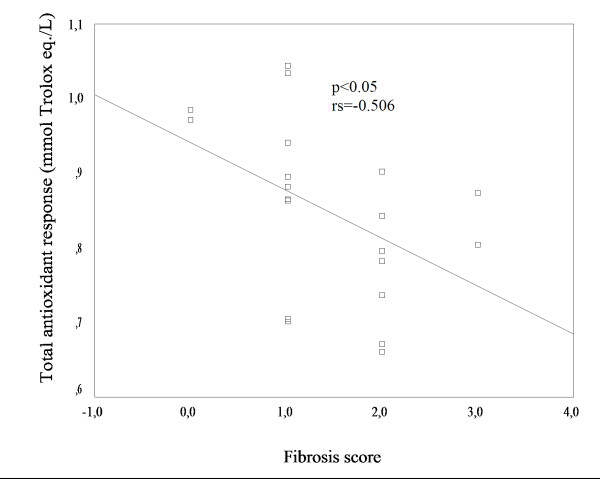
Correlation between serum total antioxidant response and the score of liver fibrosis among nonalcoholic steatohepatitis group.